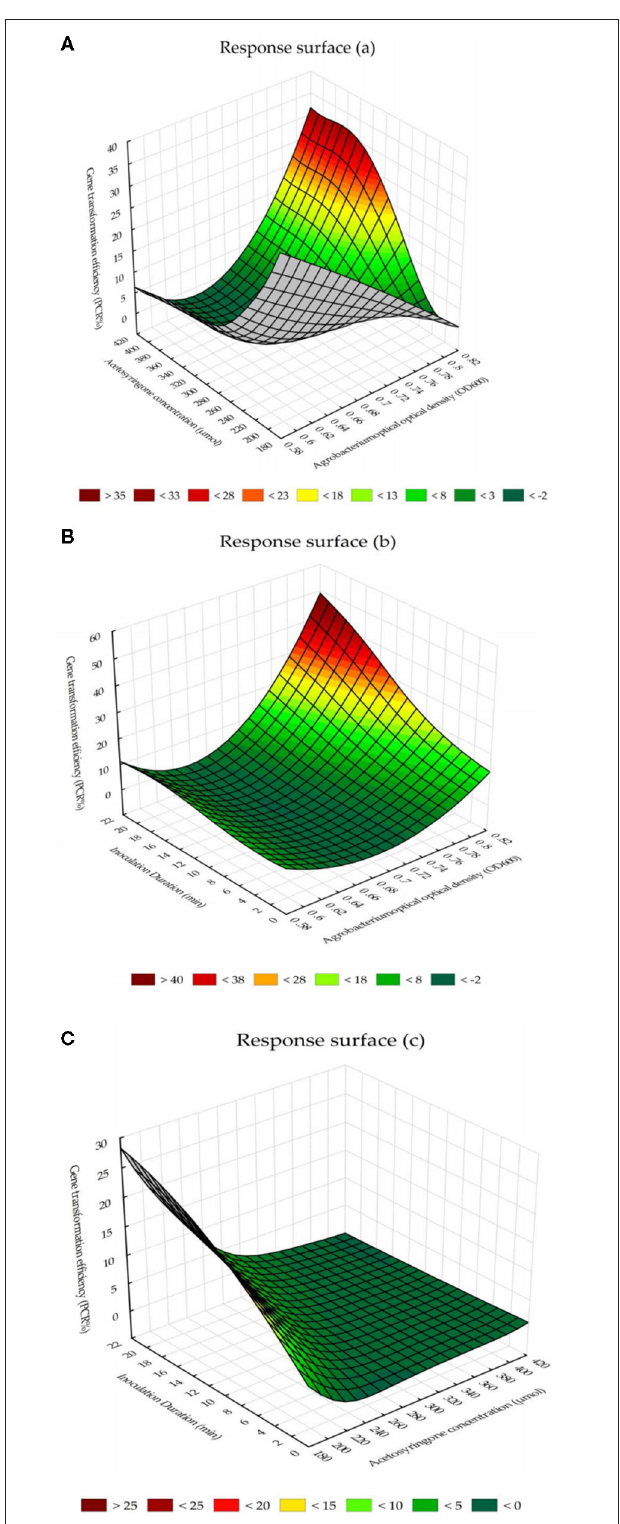
FIGURE 4 | The response surface for the interaction effects of Agrobacterium -mediated gene transformation parameters on PCR-verified